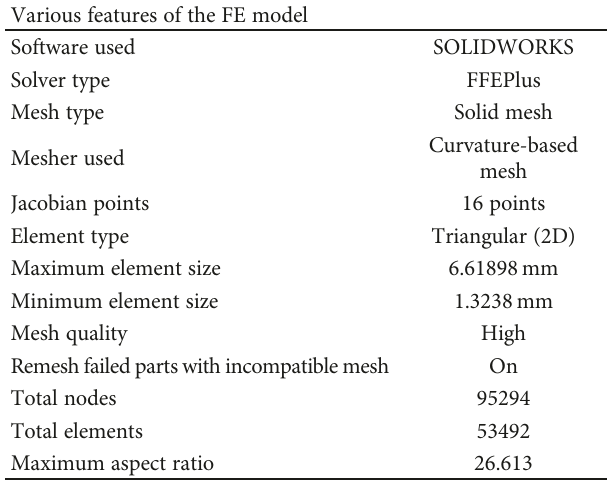
Table 4: Key features of fi nite-element modeling of knee joint components.